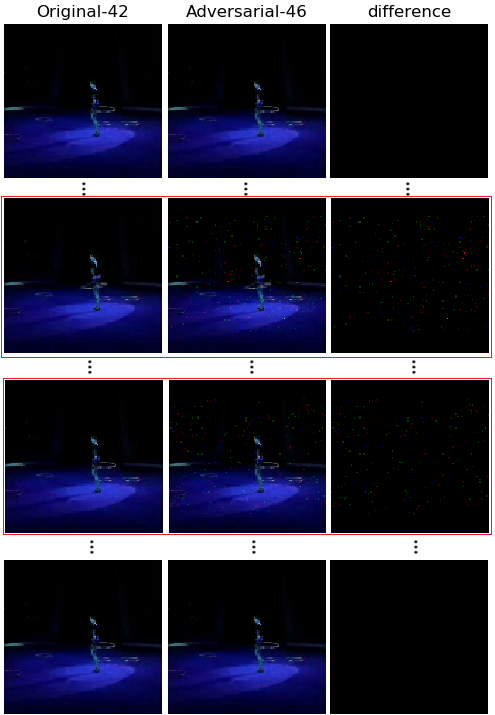
Figure 5. Other examples of adversarial frames generated by our algorithm in black-box adversarial attack. The clean video ( left ) can be classified correctly. The adversarial video ( middle ) with two disturbed frames is misclassified. The difference is shown as ( right ). The label 42 is “HulaHoop”, while the label 46 is ‘JumpingJack’. The red square is the perturbed frame of that